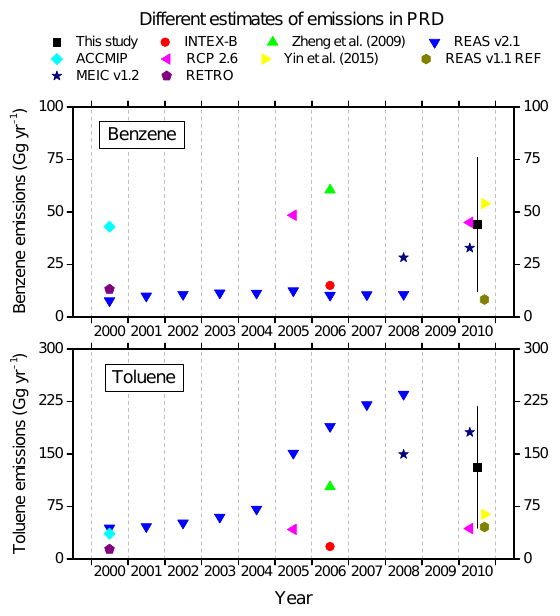
Figure 8. Estimates of benzene and toluene emissions in the PRD region for the period